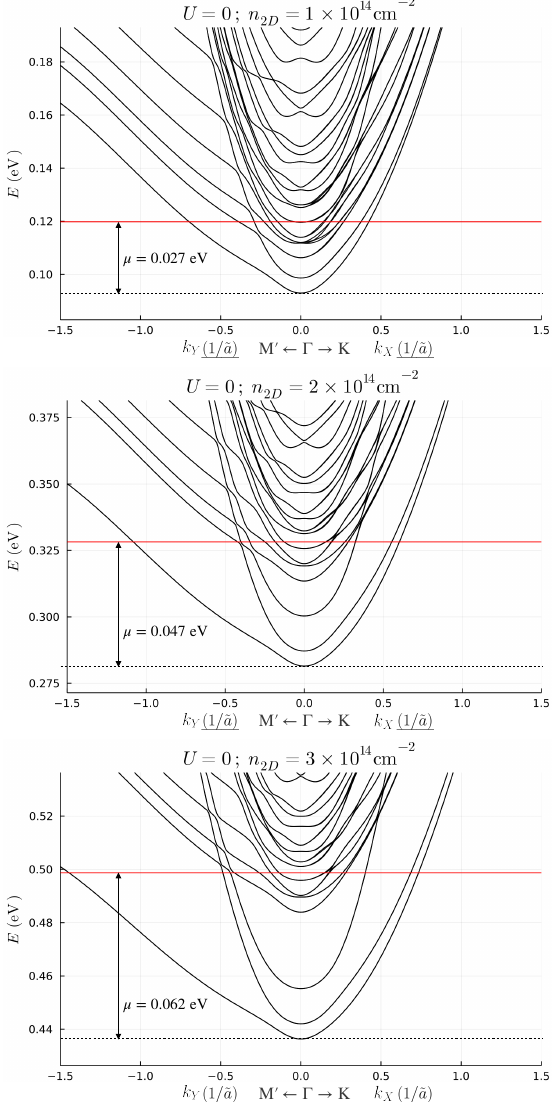
Figure 2. Low filling electronic band structure for the benchmark choice of density n 2 D = 1 × 10 14 cm − 2 ( upper panel ), n 2 D = 2 × 10 14 cm − 2 ( middle panel ) and n 2 D = 3 × 10 14 cm − 2 ( lower panel ). The red lines are the Fermi levels of the system.